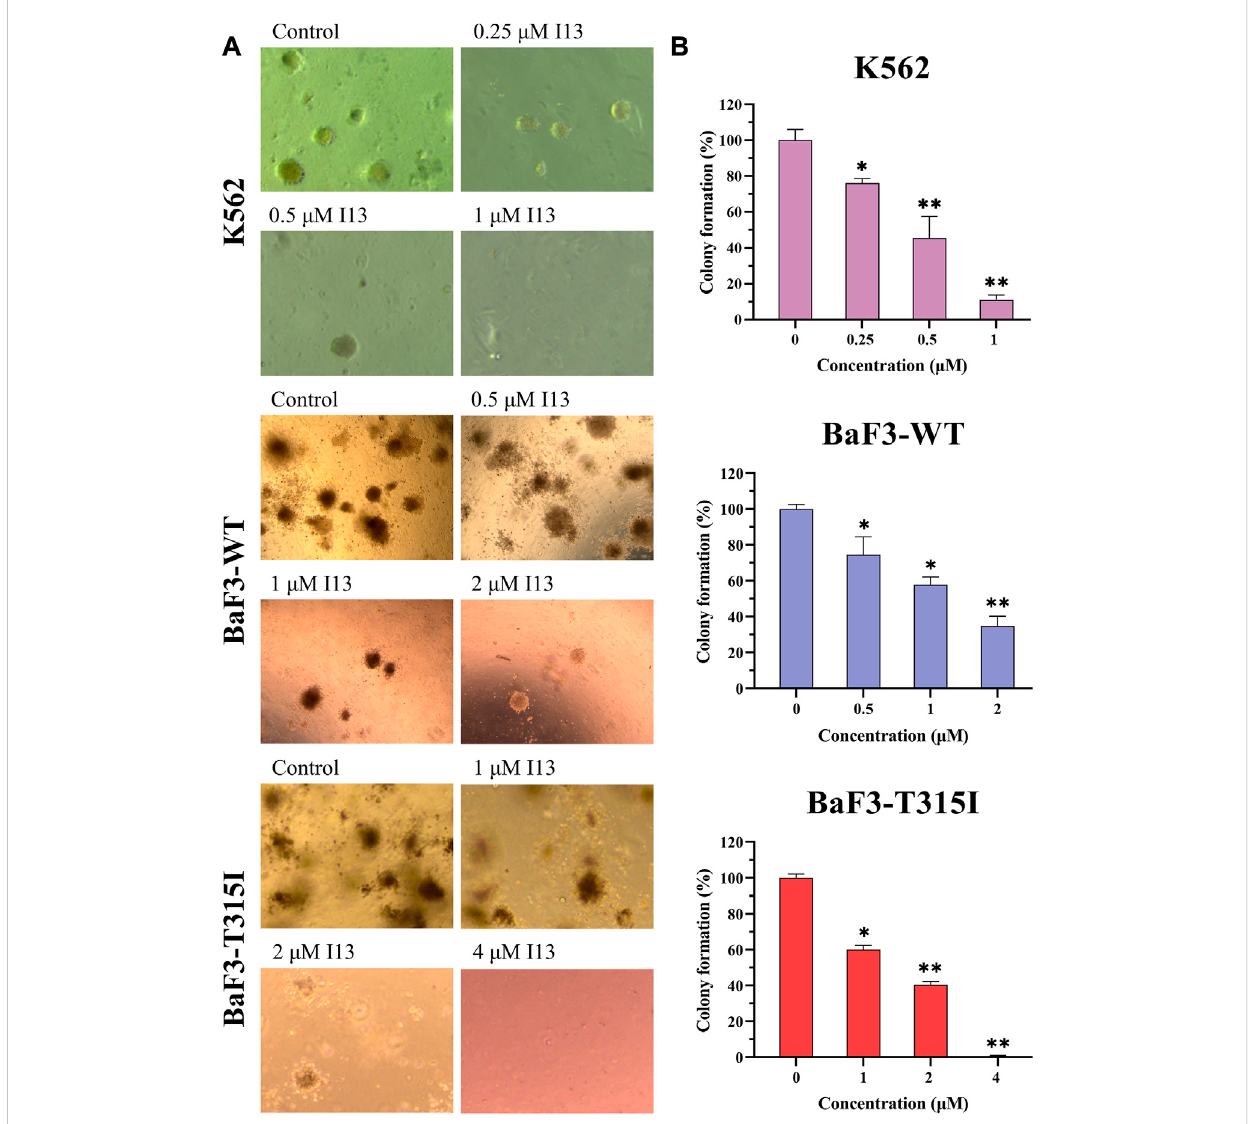
The effect of I13 on the colony-forming ef fi ciency of K562, BaF3-WT, and BaF3-T315I cells. (A) Colony formation assay of cells exposed to I13 in a methylcellulose medium. (B) The relationship of the number of colony formation assays to the concentration of I13 is shown in the bar graph (* p < 0.05, ** p <